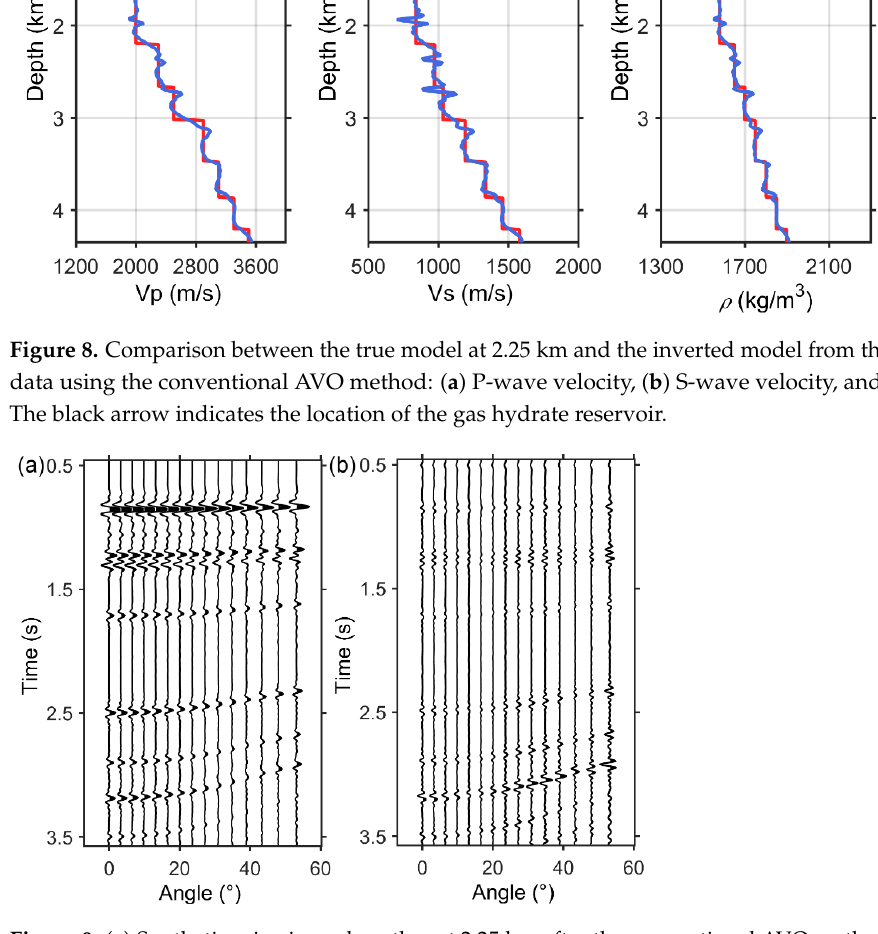
Figure 9. ( a ) Synthetic seismic angle gather at 2.25 km after the conventional AVO method, ( b ) difference between the real seismic gather in Figure 5b and synthetic seismic gather in ( a ).